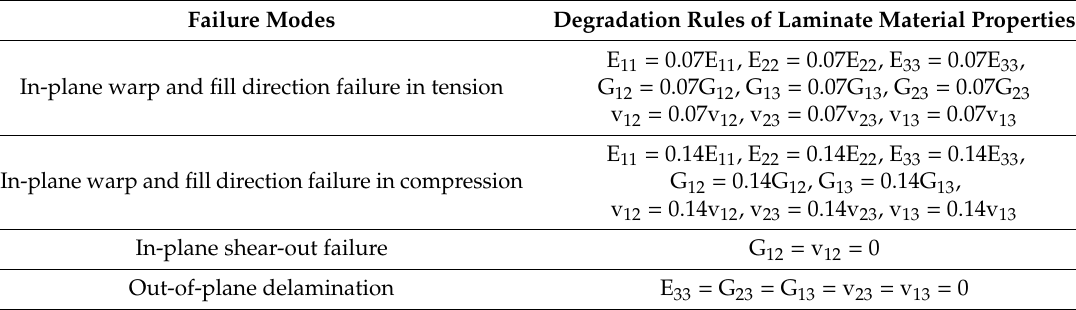
Table 4. Degradation rules of laminate material